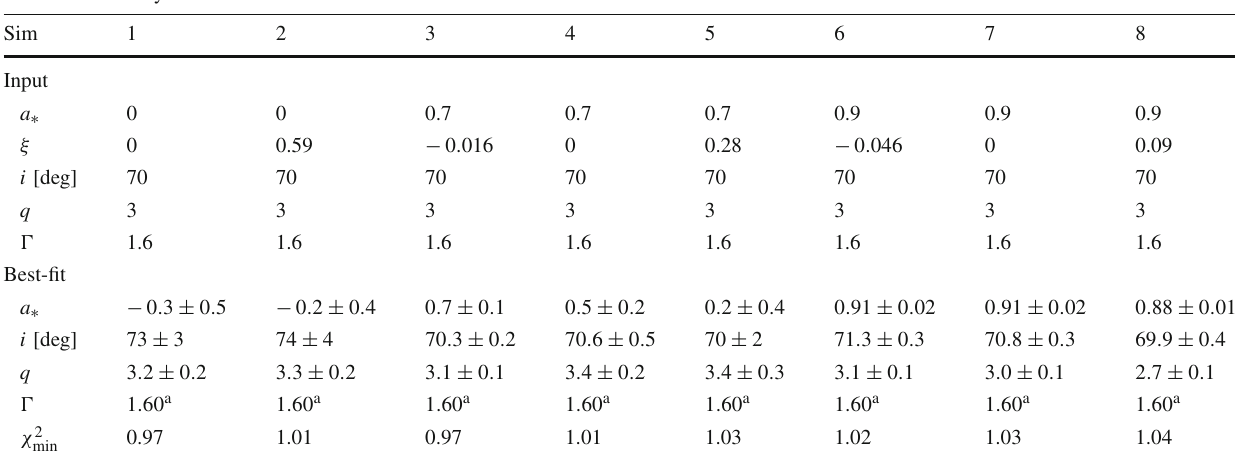
Fig. 3 As in Fig. 2 for a ∗ = 2 / Table 1 Summary of the best-fit values of simulations 1–8